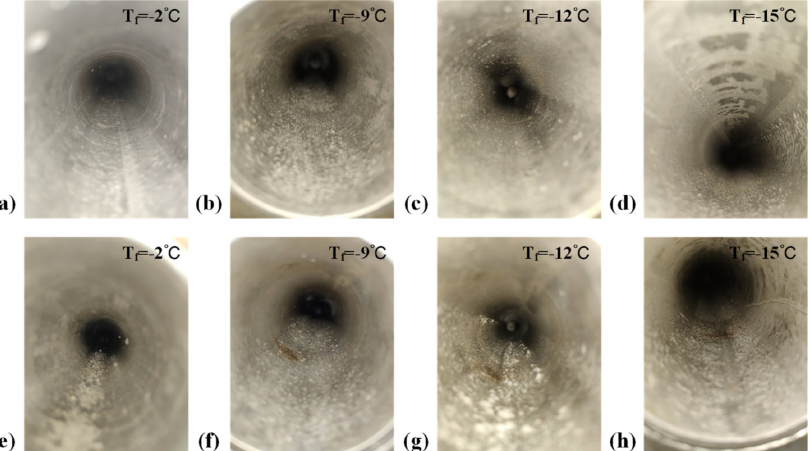
Figure 7. Ice accretion in the test sections at different fuel temperatures at t = 2 h, γ TS = 200 ppm, V = 600 L/h. ( a – d ) are the ice accretion at upstream test section and ( e – h ) are the ice accretion at downstream test